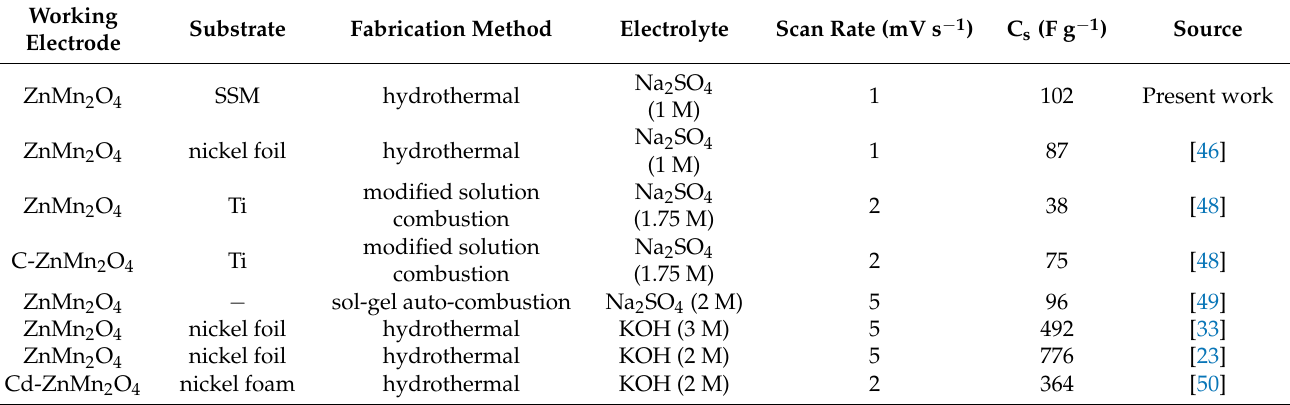
Table 5. Comparison of the specific capacitance of ZnMn 2 O 4 spinel (18 h) with previous